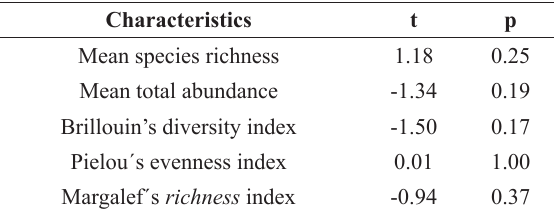
Characteristics of the metazoan parasites infracommunities found in Hoplosternum littorale (Hancock 1828) from two locations in the Peixe River, Middle Tietê River, São Paulo State, Brazil. t = values of the Student t-test for the comparison between the two